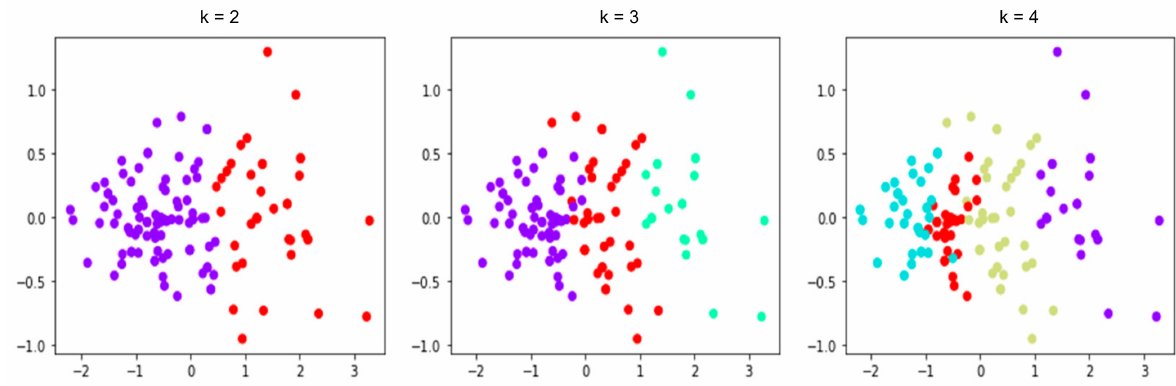
Figure 5. The agglomerative clustering algorithm results while the different numbers of clusters are taken into consideration. Then, the score of the PCA-Ward method is measured with the different cluster numbers and shown in Figures 6–11.